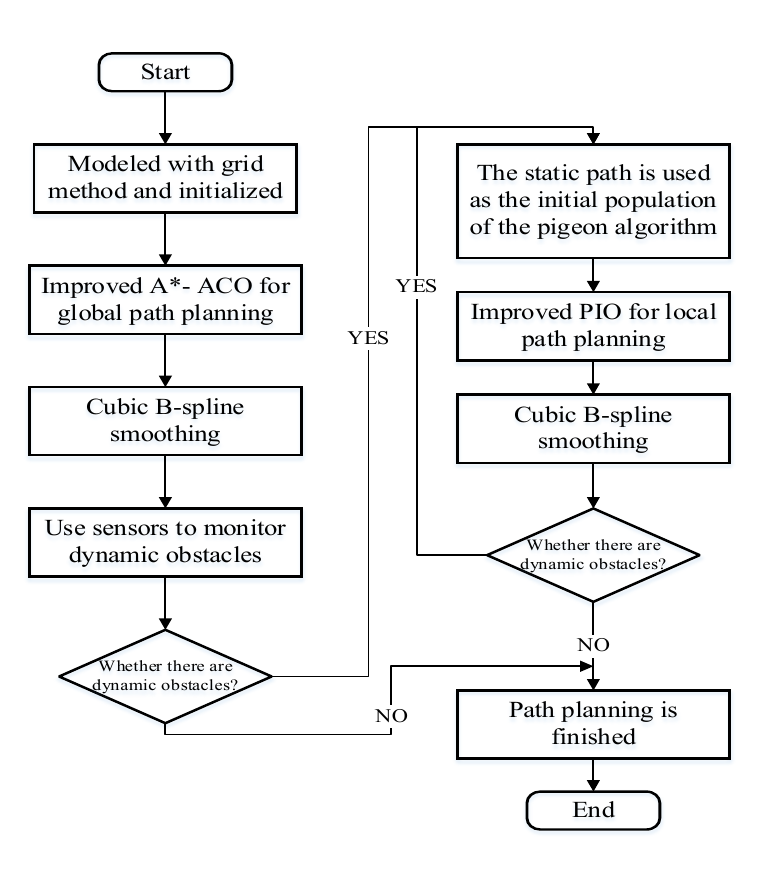
Figure 5. Proposed path planning process.